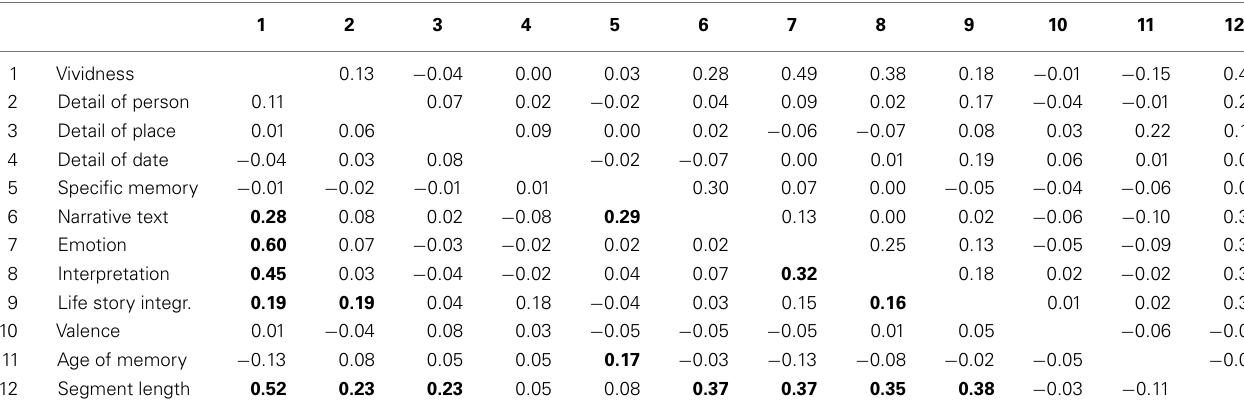
Table 1 | Correlations between aspects of memory reports ( N = 3075 segments, upper right triangle) and means of correlations within participants ( N = 168 participants, lower left triangle; significant correlations in